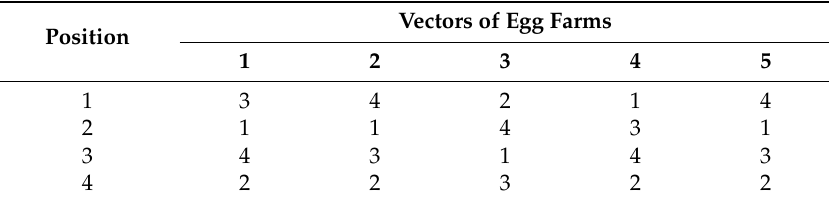
Table 6. Positions of initial vectors of egg farms.